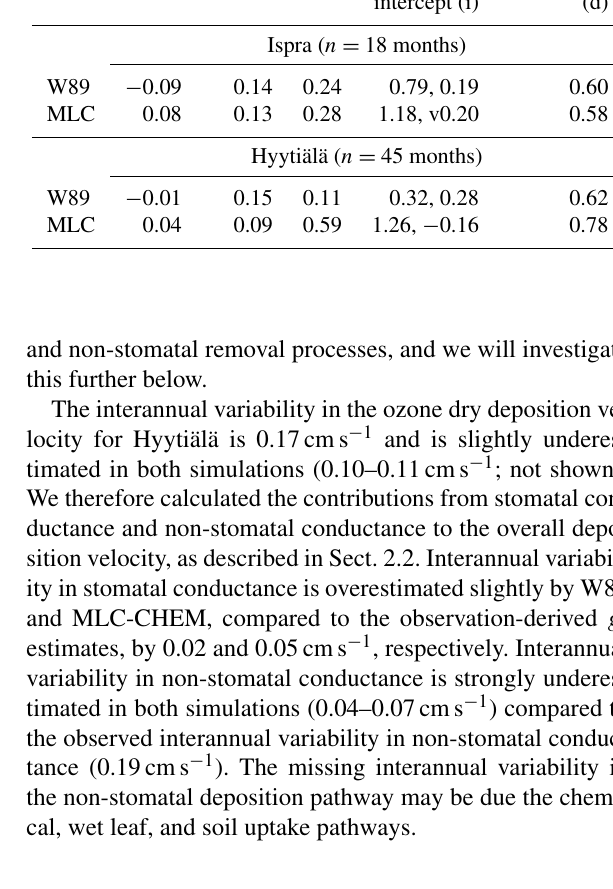
Table 1. Performance statistics for the monthly averaged simula- tions of V d (O 3 ) with W89 and MLC-CHEM (MLC). The unit is centimeters per second (cms − 1 )for mean bias error (MBE), root mean square error (RMSE), and the intercept and unitless for the other metrics. Shown are several conventionally applied perfor- mance metrics (MBE, RMSE, slope (s) and intercept (i) of a linear regression fit of simulations against observations and r 2 from the ordinary least squares regression) and the index of agreement (d). MBE RMSE r 2 Slope (s), Agreement intercept (i) (d) Ispra ( n = 18 months) W89 − 0.09 0.14 0.24 0.79, 0.19 0.60 MLC 0.08 0.13 0.28 1.18, v0.20 0.58 Hyytiälä ( n = 45 months) W89 − 0.01 0.15 0.11 0.32, 0.28 0.62 MLC 0.04 0.09 0.59 1.26, − 0.16